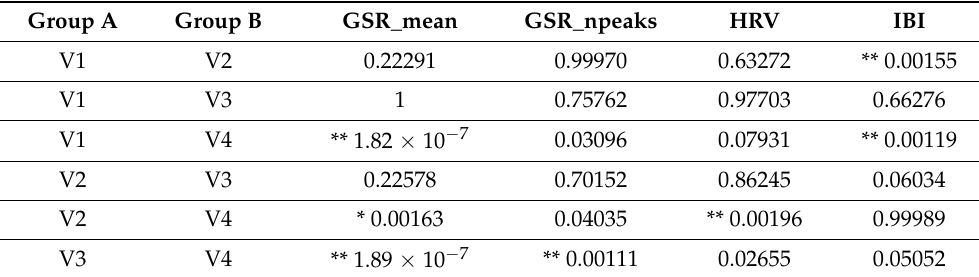
Table 4. p -values results from Kruskal-Wallis one-way ANOVA test for physiological data grouped by video